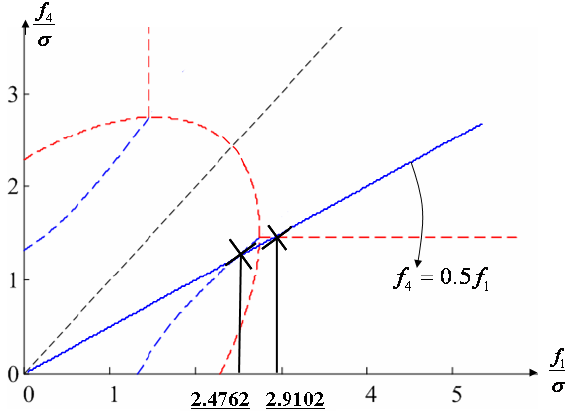
Figure 20. Accommodation rule for 1 st and 4 th faulty sensors in Figure 14.